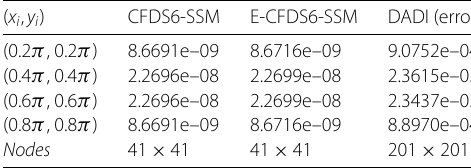
Table 5 The error of two different schemes for SP 3 at t = 2